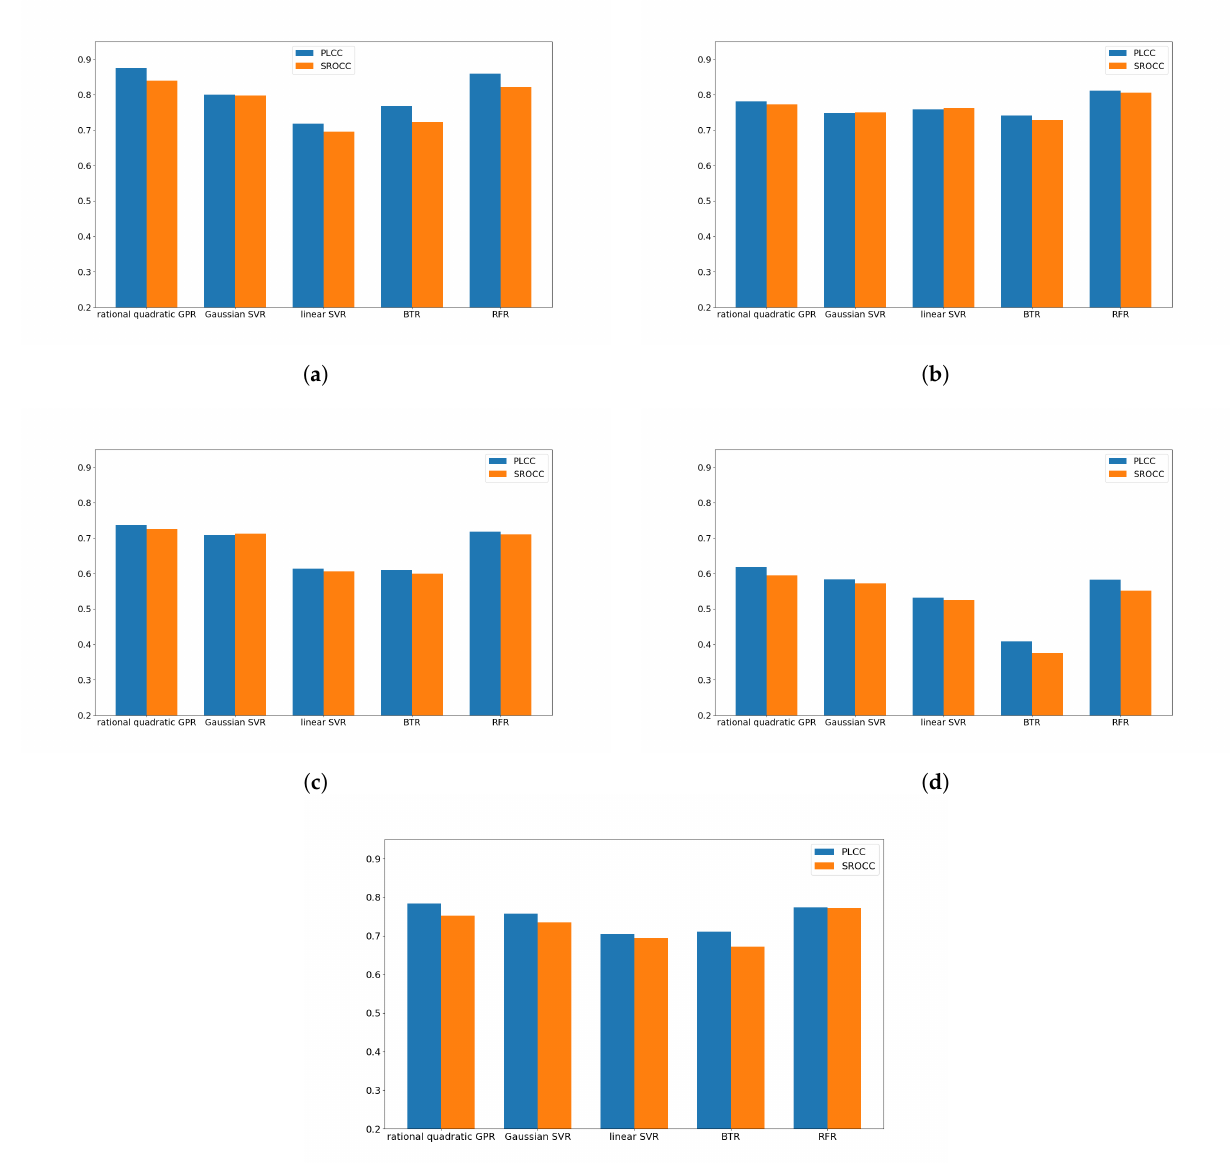
Figure 5. Performance comparison of rational quadratic Gaussian process regressor (GPR), Gaussian support vector regressor (SVR), linear SVR, binary tree regression (BTR), and random forest regression (RFR) techniques. Average Pearson’s linear correlation coefficient (PLCC) and Spearman’s rank order correlation coefficient (SROCC) values measured 100 random train–test splits are plotted. ( a ) CSIQ [58]. ( b ) MDID [59]. ( c ) KADID-10k [46]. ( d ) LIVE In the Wild [35]. ( e ) KonIQ-10k